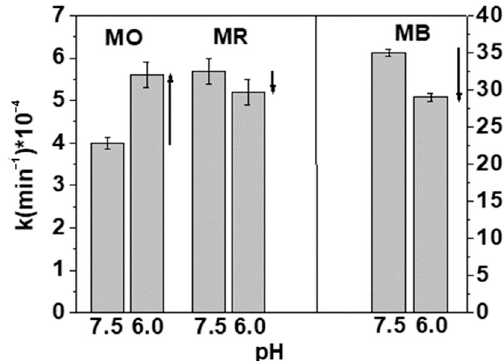
Figure 7. Apparent rate constants in tap water (pH = 7.5) and distilled water (pH = 6) at 120 W